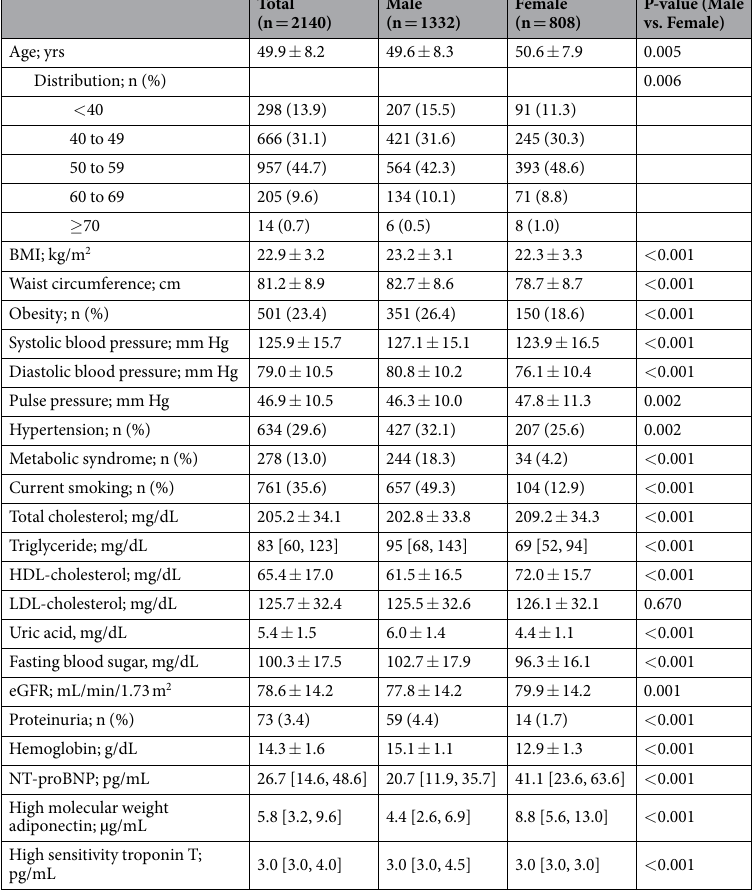
Table 1. Baseline characteristics. Data are shown as Mean ± SD, Median [IQR], or n (%). Each P value was calculated t-test for variables with normal distribution and Mann-Whitney U test for skewed distribution. BMI = body mass index, eGFR = estimated glomerular filtration ratio, HDL = high-density lipoprotein, hsTnT = high-sensitivity troponin T, LDL = low-density lipoprotein, NT-proBNP = N-terminal pro-brain natriuretic